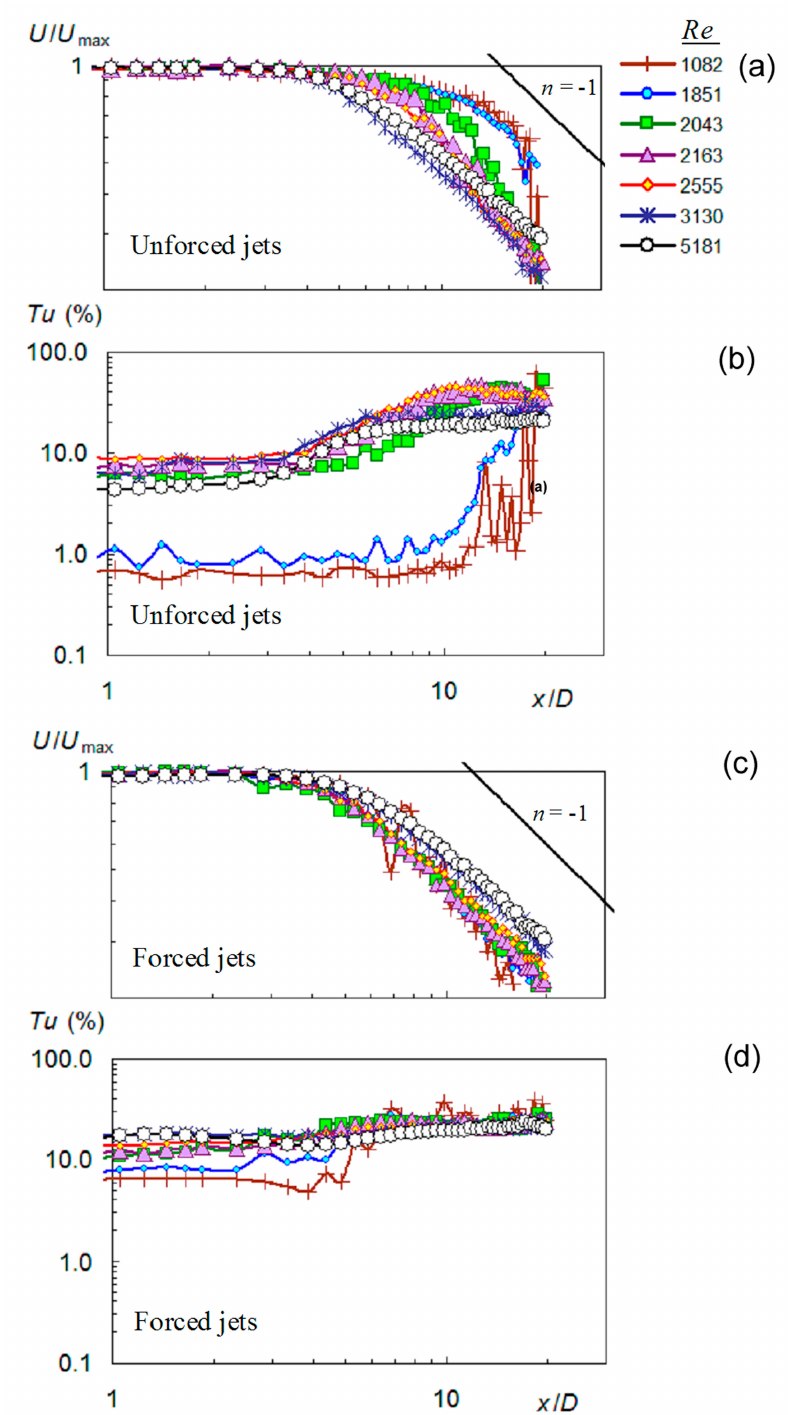
Figure 4. Axial velocity profiles of ( a , b ) unforced jets and ( c , d ) forced jets; ( a , c ) dimensionless time- mean velocity components, ( b , d ) turbulence intensities. For better clarity, the data set was plotted in a reduced